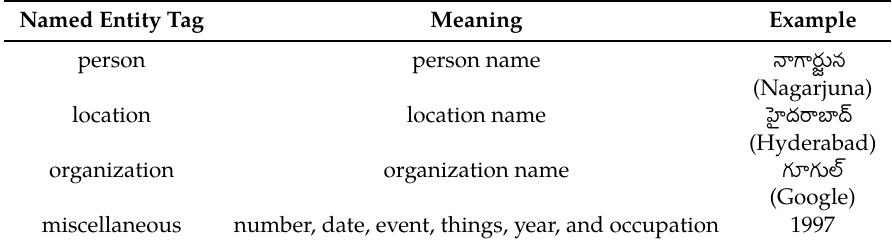
Table 2. Named entity